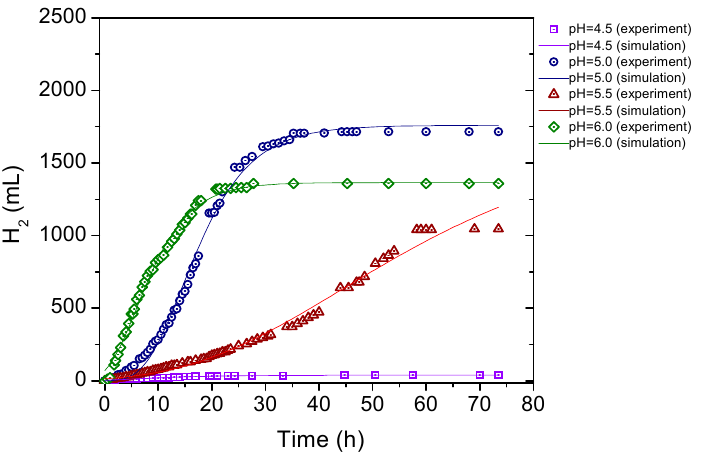
Figure 3. Cumulative hydrogen production (experimental data and modified Gompertz model simulation) at different pH values tested. Table 3. Kinetic parameters of hydrogen production estimated using the modified Gompertz equa- tion.